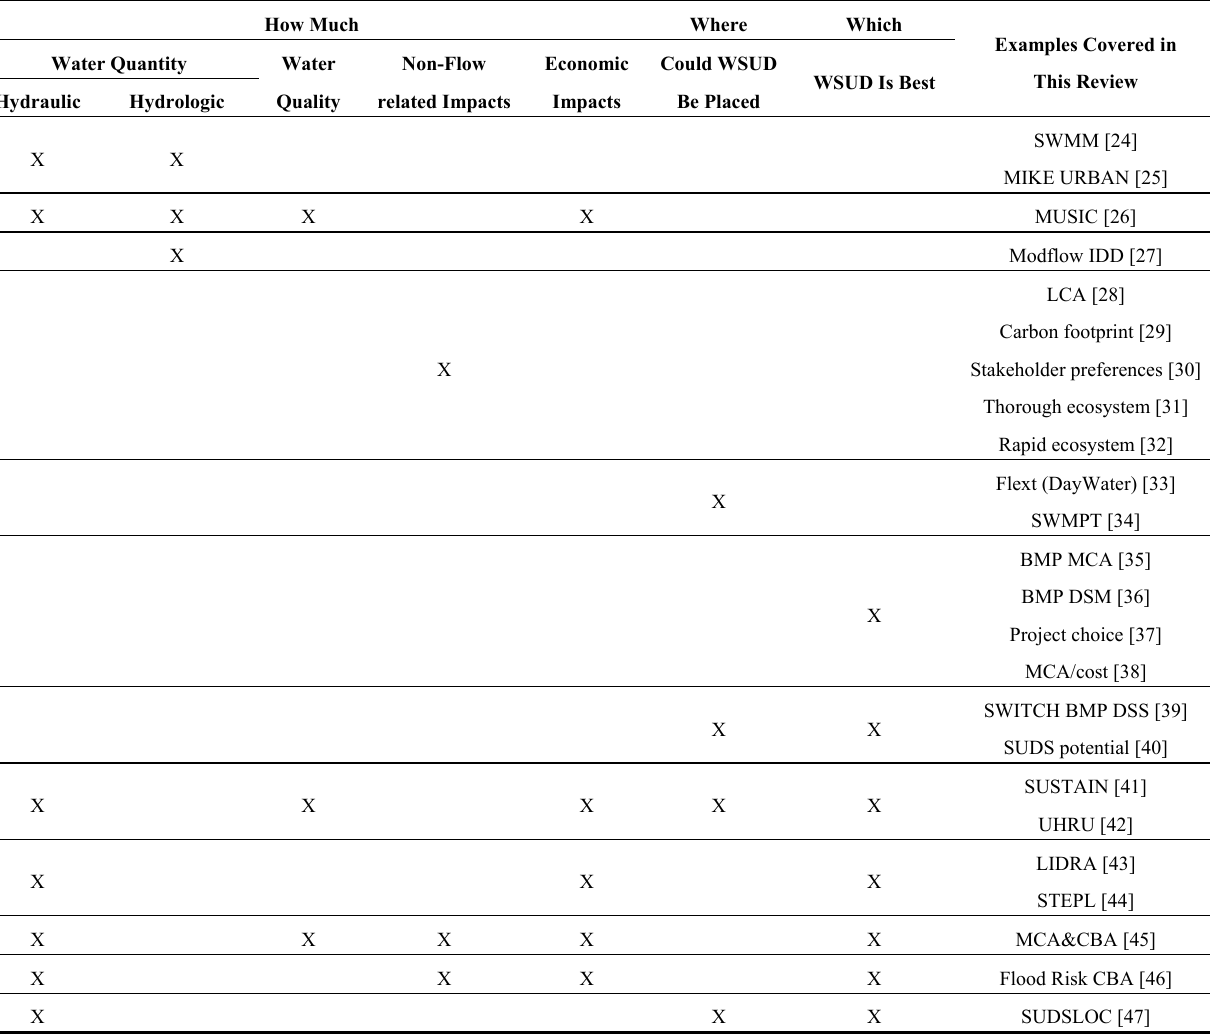
Table 2. The headings of this table present a structure for categorizing types of questions answered by WSUD decision support tools. The right column contains examples of tools that are further described in the following sections. The tools are grouped (indicated by the horizontal lines) according to which types of questions they may help in answering (indicated by the